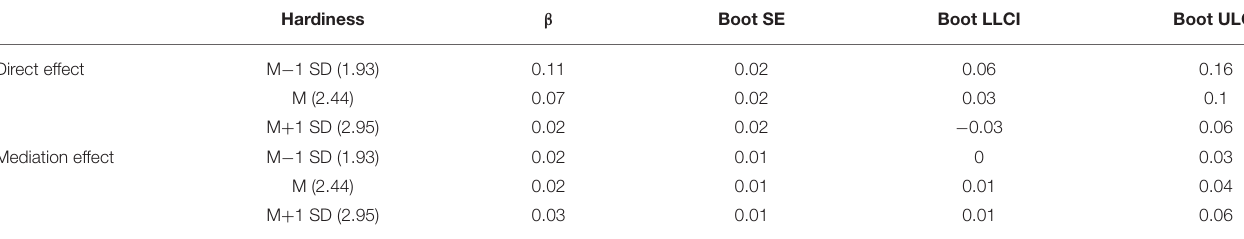
TABLE 5 | Direct effect and mediating effect on different levels of